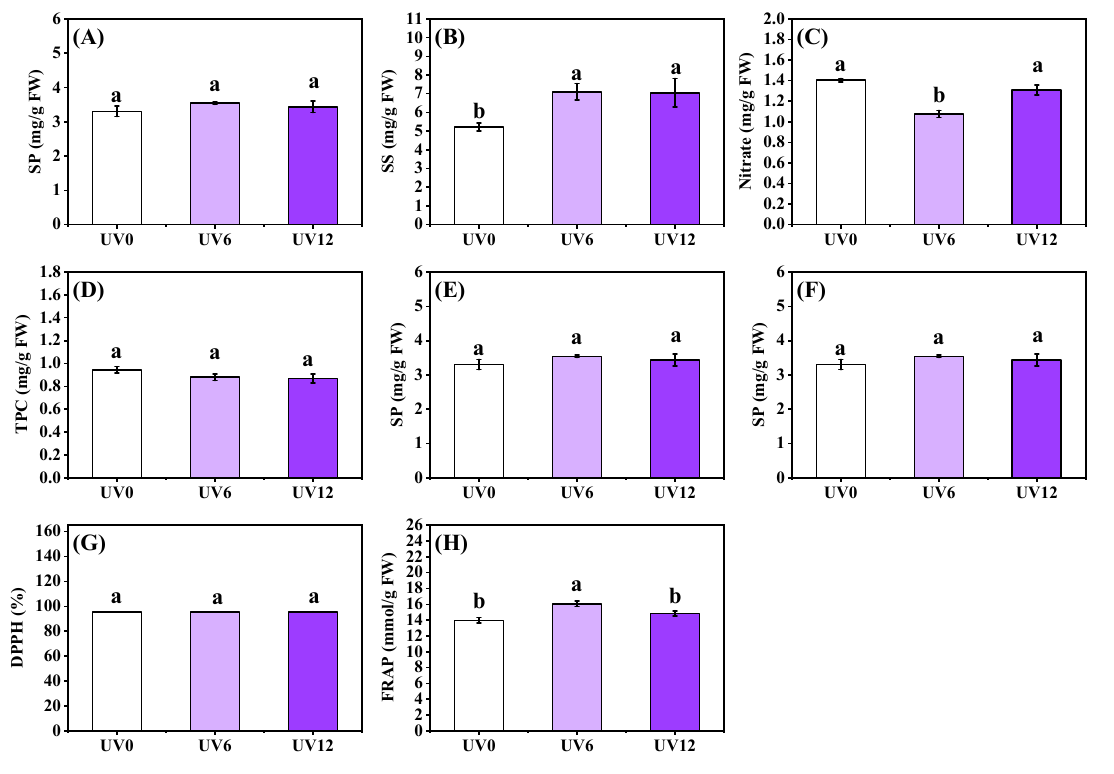
Figure 5. Shoot phytochemical contents of Chinese kale subjected to different durations of UVA- radiation exposure. ( A ) SP. ( B ) SS. ( C ) Nitrate. ( D ) VC. ( E ) TF. ( F ) TPC. ( G ) DPPH. ( H ) FRAP. Different lowercase letters (a,b) labeled on the vertical bar (means ± standard error, n = 3) represent significant differences by one-way ANOVA with multiple-range tests ( p ≤ 0.05).